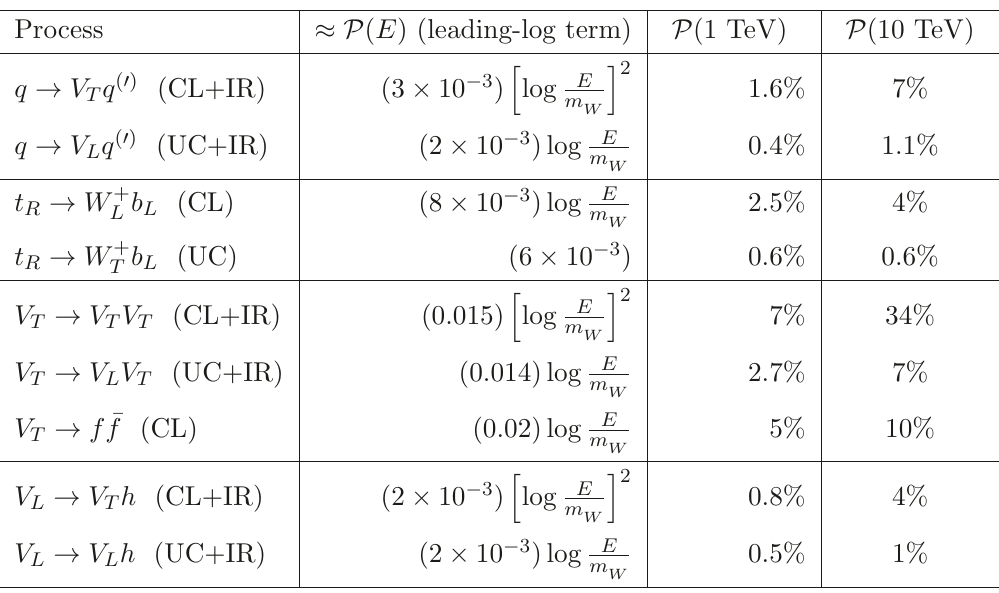
Table 7. Representative electroweak splitting behaviors and integrated fixed-order splitting prob- abilities for an illustrative set of processes at two parent energies E = 1 , 10 TeV. The symbols in the parentheses denote the collinear (CL), infrared (IR), and ultra-collinear (UC) behaviors,